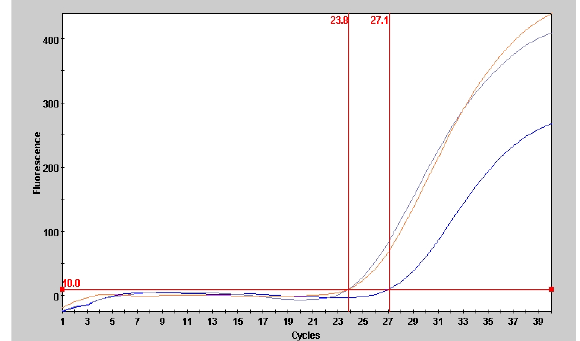
Figure, 2: RT- PCR amplification plot of G gene of ILT virus of three laryngeal and tracheal samples indicate positive result with FAM labeled probe: Abbas Kareem Co.of broiler breeders 31 weeks, Diala. Al-safaa Co.brown table egg layers 28 weeks, Diwania. Wasit Co.broiler breeders 32 weeks at Wasit City.